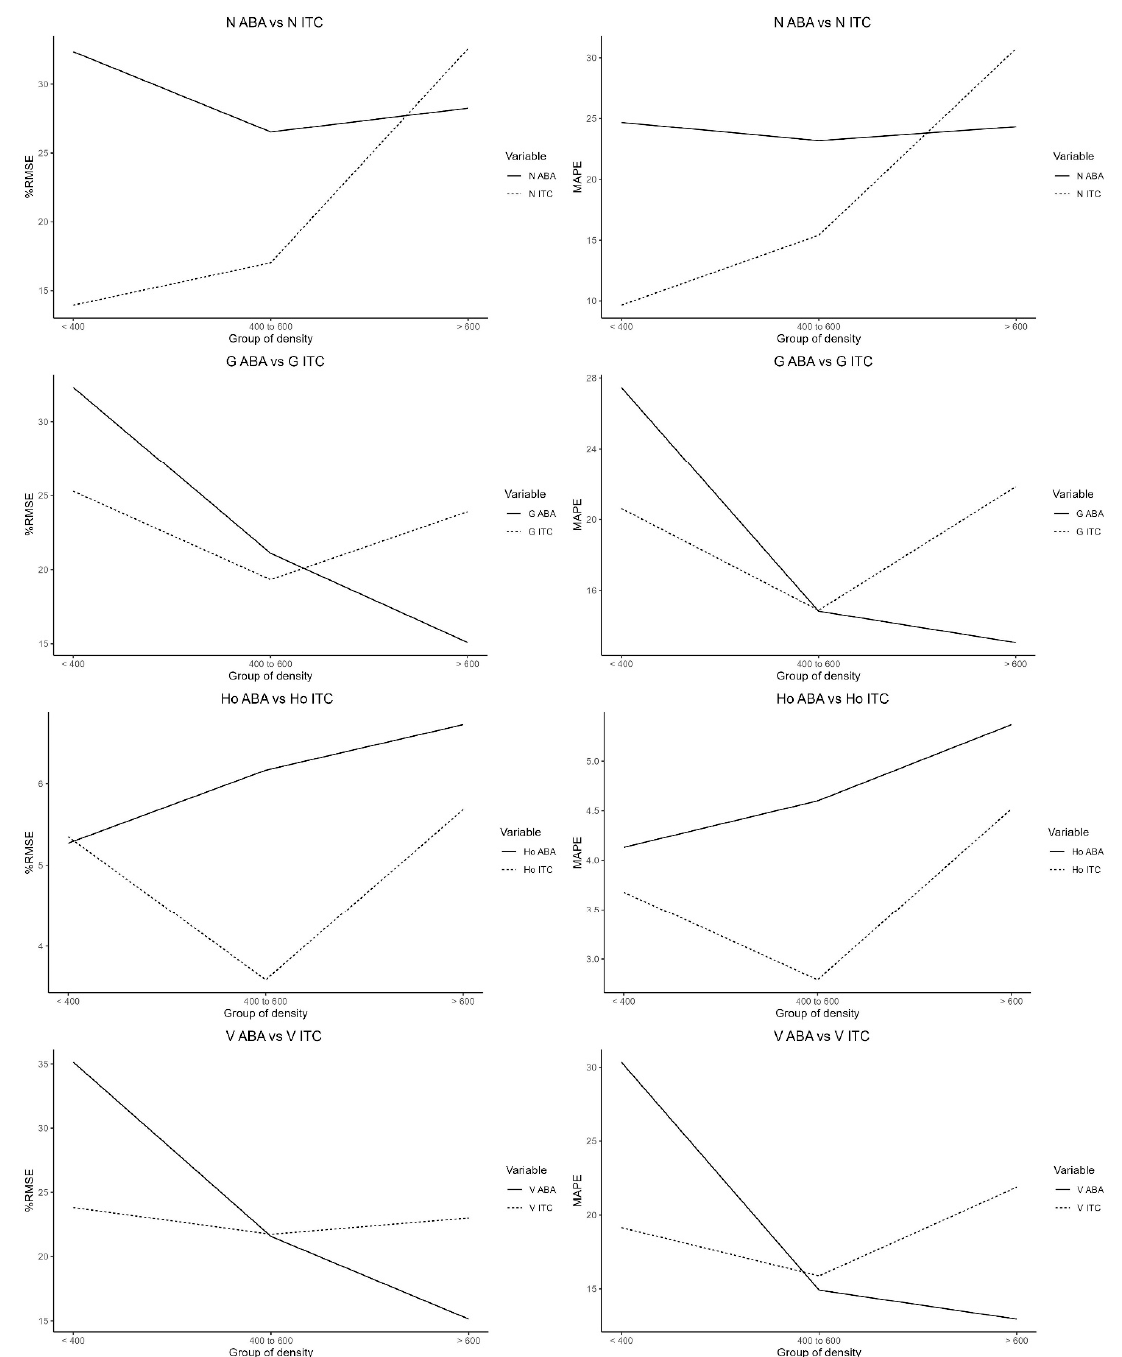
Figure 5. Distribution of errors (%RMSE and MAPE) in the estimation of the forest inventory attributes of Pinus radiata stands in the Ñuble Region (South, Chile) using the Area-Based Approach (ABA) and Individual Tree Crown (ITC) models (see Table 2, n = 48 plots) as a function of plot density in intervals of 200 trees ha − 1 . Density (N, trees ha − 1 ), Assman´s dominant height (Ho, m), Basal area (G, m 2 ha − 1 ), Volume (V, m 3 ha − 1 ).